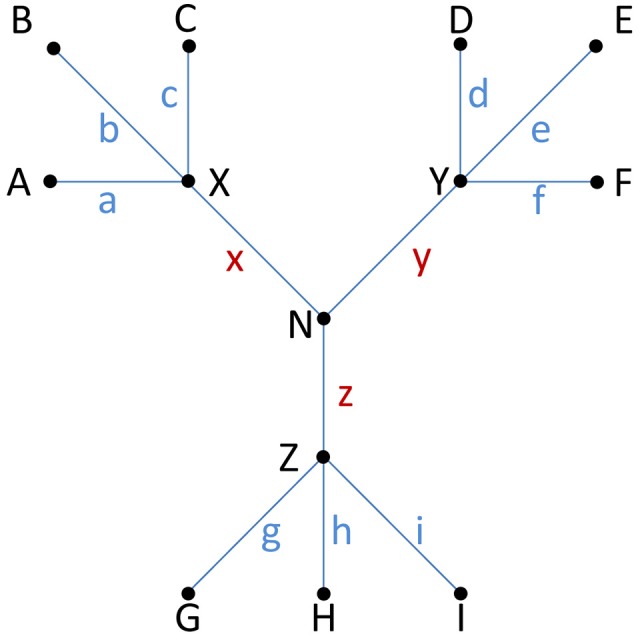
Isogenic or non-isogenic isolates? The distance or number of observed differences between isolates, usually measured as single nucleotide polymorphisms (SNPs) in HTS studies, can provide clues to determine if isolates belong to the same strain, i.e., whether they are isogenic or not. This is important for outbreak investigations, epidemiology and to assess if a persistent strain is present in a food production system. Fewer than ten SNPs is often interpreted as evidence of an isogenic origin of bacterial isolates (see examples and discussion in the main text of this paper). Practice is currently not harmonized and also depends on the taxon in question, how SNPs or other differences are calculated, and which part of the genome the study covers (e.g., core or whole genome). An inferred phylogenetic relationship between nine isolates (A–I; terminal nodes) is shown. For each isolate, a blue letter (a–i) indicates the number of unique SNPs associated with each individual isolate. Internal nodes labeled X–Z connect three clusters of isolates, while internode N connects all isolates. Brown letters (x–z) indicate the number of shared SNPs separating each individual cluster of isolates from the others. The distance (Δ) between any pair of isolates is the sum of SNPs (i.e., blue and brown letters) separating them, e.g., if a = 3, d = 2, x = 2 and y = 4 then ΔAD = 3 + 2 + 2 + 4 = 11. The following two examples serve to illustrate the difference between putatively isogenic and non-isogenic clusters of isolates (with a threshold of 9 for isogenics): If a = b = c = d = e = f = 2, g = h = i = 3, x = 2, and y = z = 3 then all the isolates A–F might be considered isogenic (internal distance between any pair of isolates Δmax ≤ 9), as might G-I (Δmax = 6), whereas A–F might not be considered isogenic with G–I (internal distance between any members from two different clusters Δmin ≥10). Similarly, if a = b = c = d = e = f = 6, g = h = i = 1, x = 1, and y = z = 3 then only isolates G–I (Δmax = 2) might be considered isogenic (any other pair of isolates would yield Δmin ≥11).